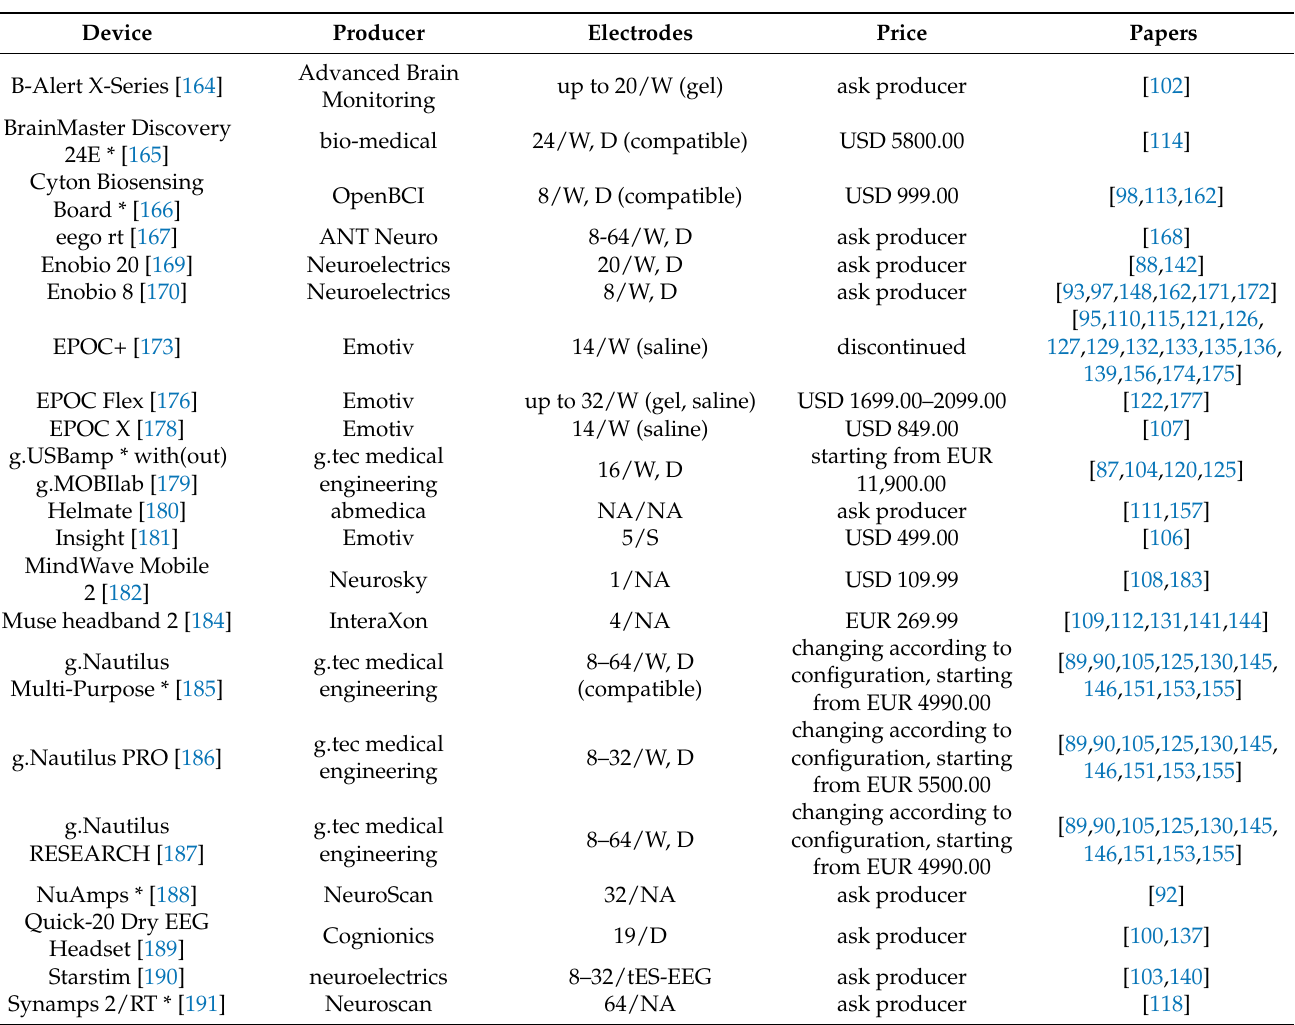
Table 4. Synthetic information on the wireless devices employed by the reviewed papers. For the Nautilus entries, it was unclear which device the authors used; thus, all the versions are reported. An asterisk (*) is present when the devices are amplifiers or data acquisition tools. Last